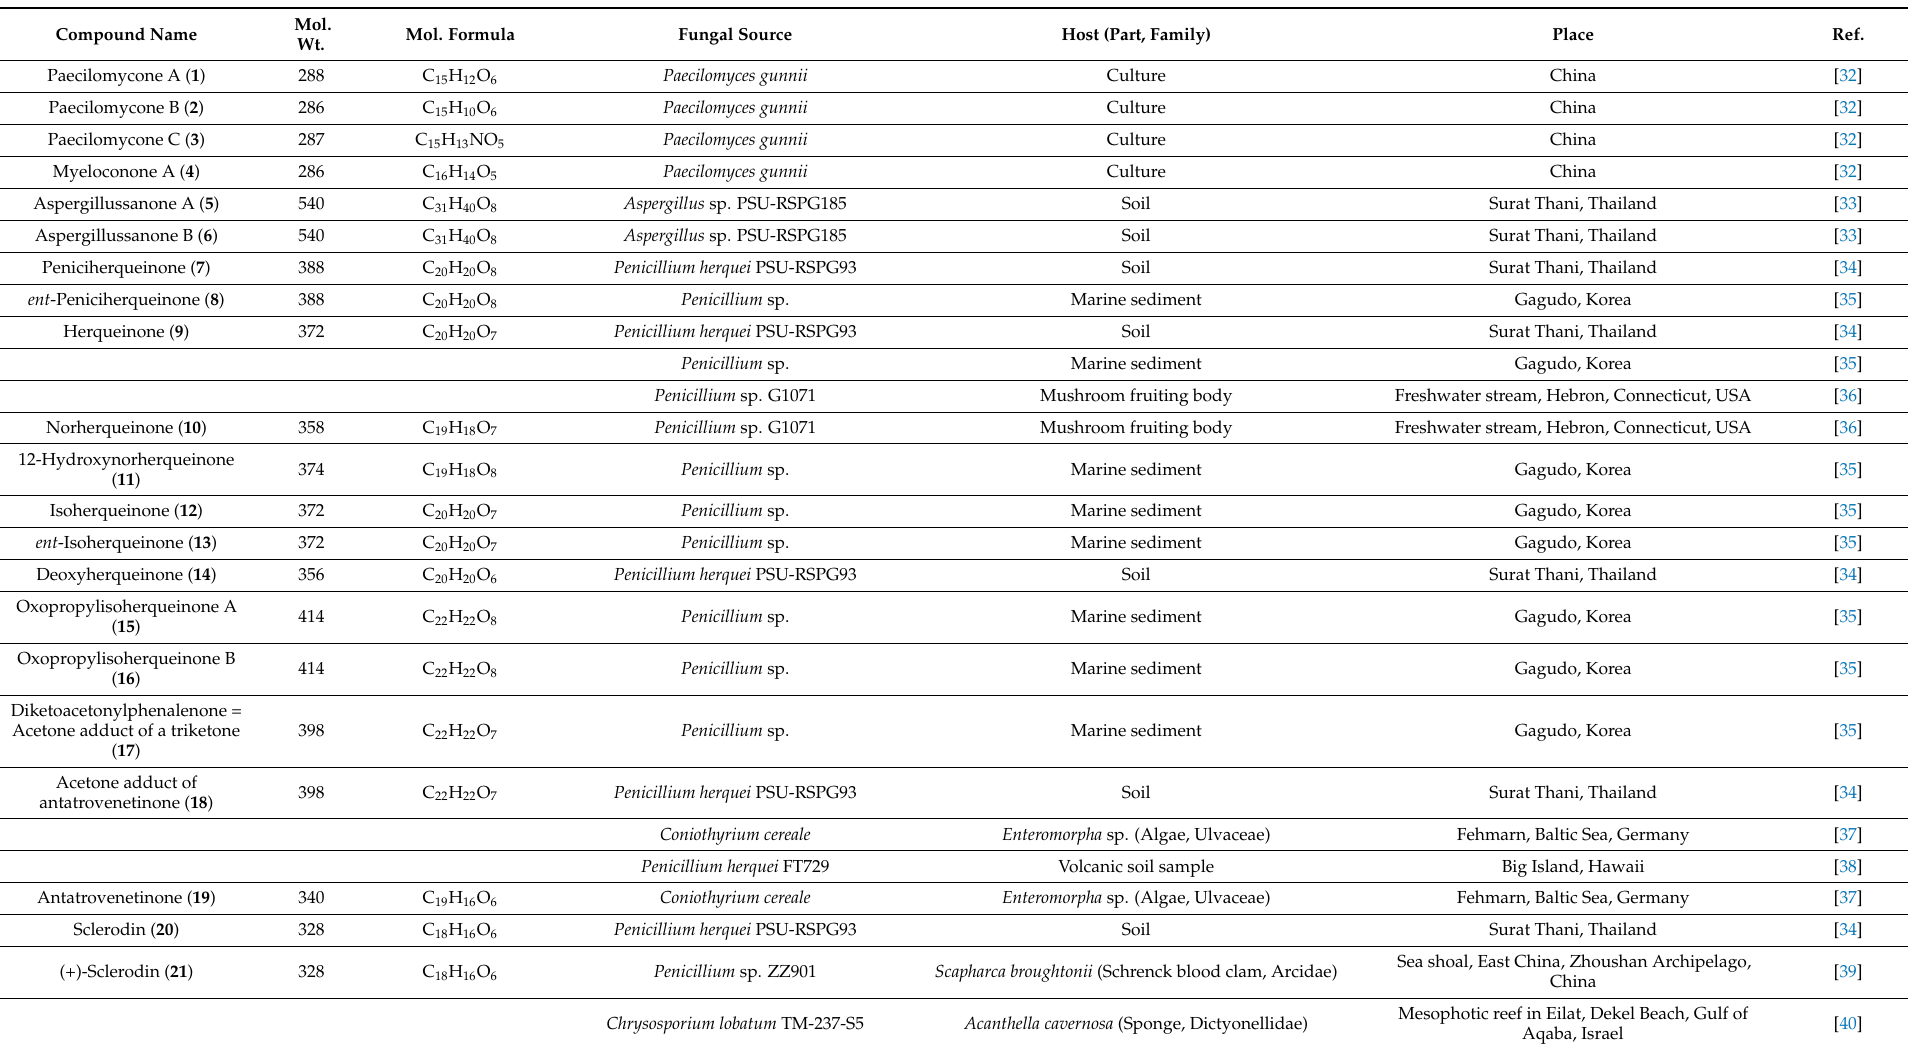
Table 1. List of fungal phenalenones (fungal source, host, and place of